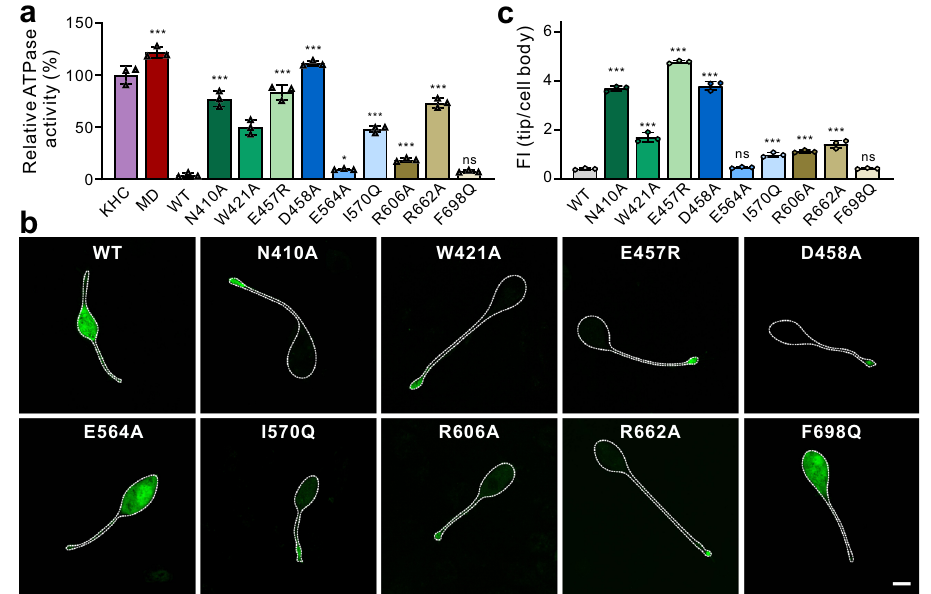
Fig. 4 | Disruptions of the interdomain interfaces restore the motor activity of KLP-6. a Microtubule-stimulated ATPase activities of the wild-type and various mutants of full-length KLP-6. Data were normalized by the microtubule-stimulated ATPase activity of KHC as 100%. Each protein sample had two replicates and each measurement was repeated three times independently. Each bar represents the mean value±SD. *** P <0.001; * P <0.05; ns, no signi fi cant difference, unpaired, two- tailed Student ’ s t test. Source data are provided as a Source Data fi le. b Cellular localizationsoffull-lengthKLP-6anditsvariousmutantsintheN2Acells.Wild-type KLP-6 was largely localized in the cell body, while most of the mutants showed